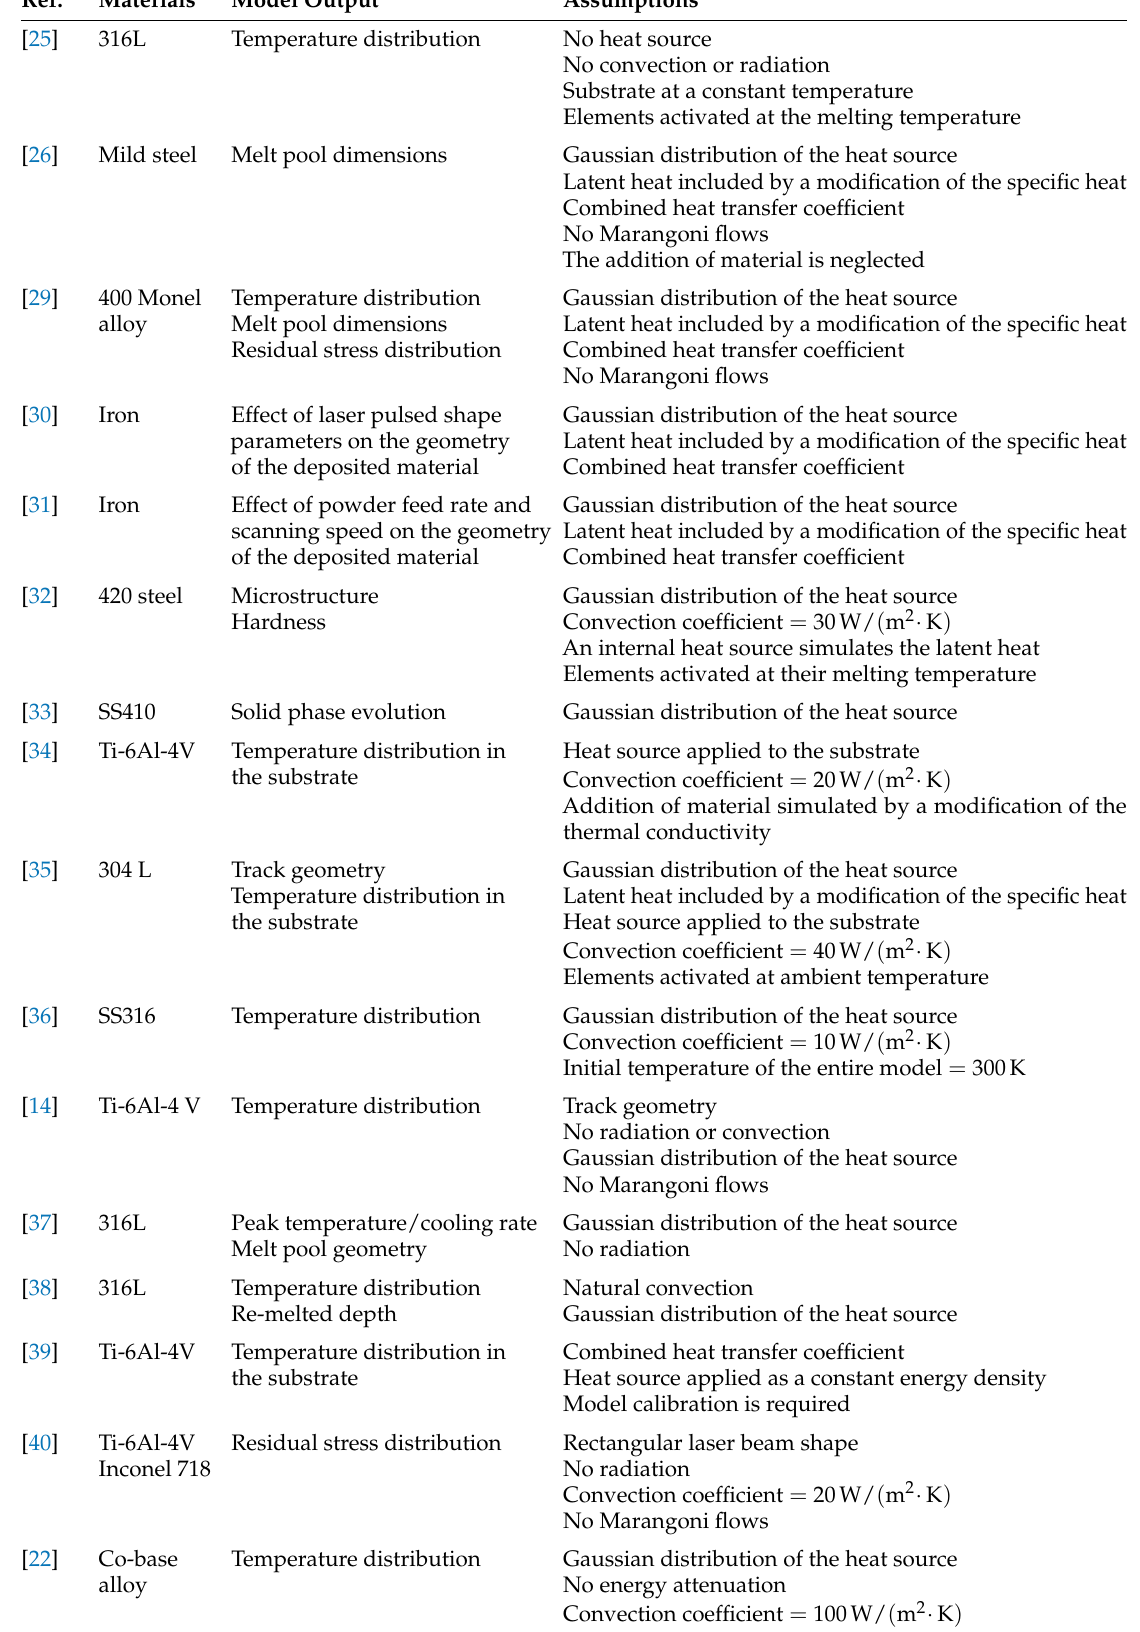
Table 1. Summary of the LP-DED models available in the literature.